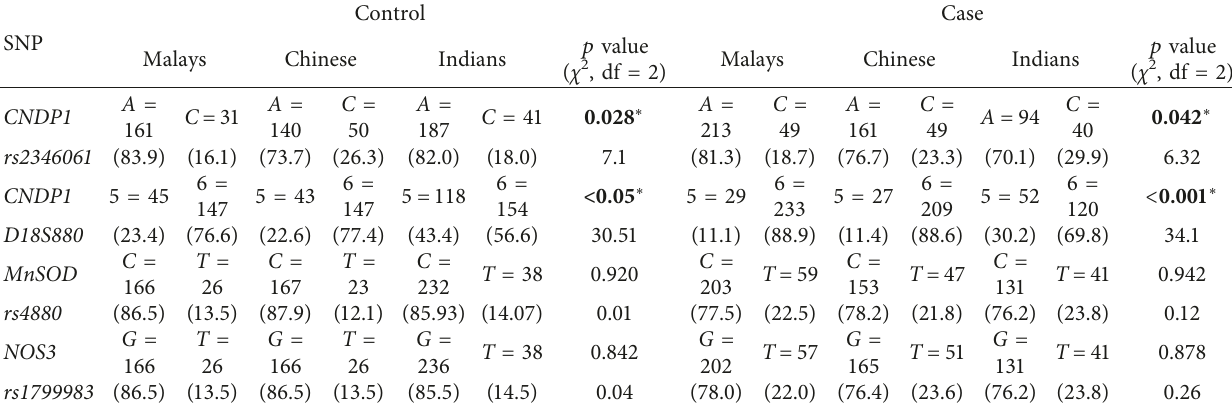
∗ p < 0 . 05 indicates the significant difference in allele distribution in the